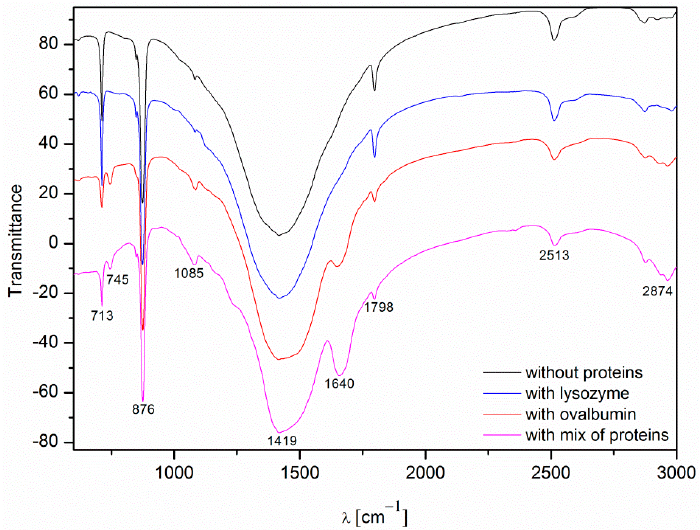
Figure 9. FTIR spectra of the calcium carbonate crystals obtained in the absence and in the presence of proteins (0.1%, after 10 min). Table 1. The band assignment of the FTIR vibrations of the calcium carbonate particles precipitated in the absence and presence of proteins [4,10,39–41].